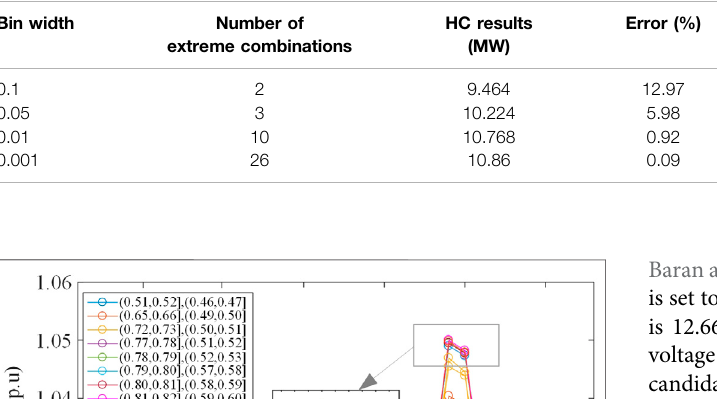
TABLE 2 | Hosting capacity results with different bin widths.